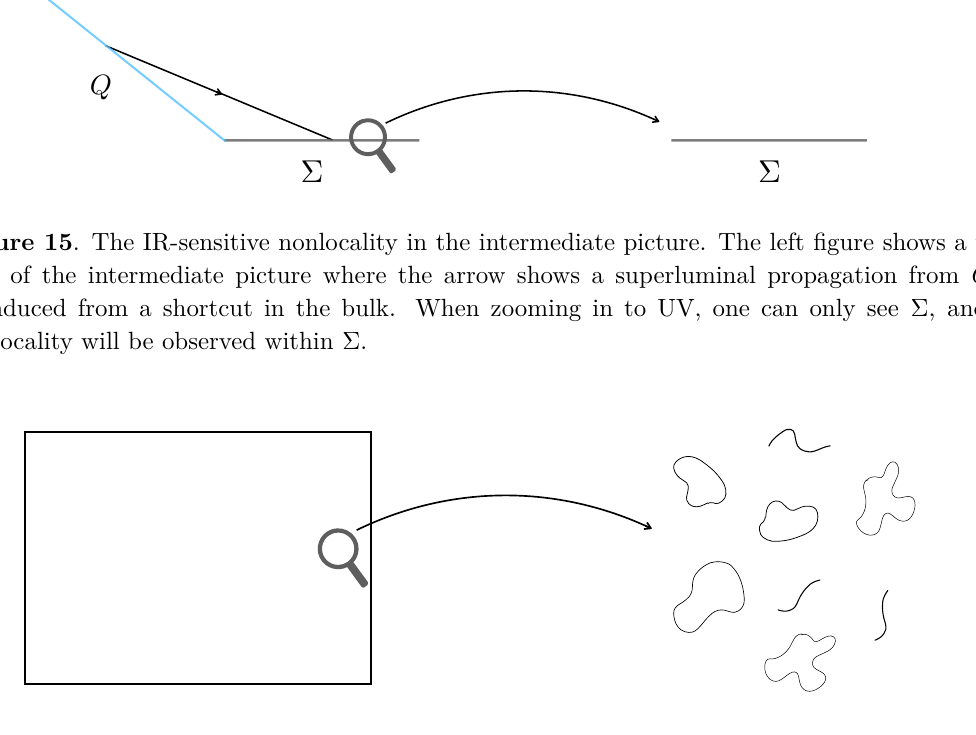
Figure 16 . The UV-sensitive nonlocality known in the string theory. When zooming in a field theory (left) which has a string origin to UV, nonlocality caused by the extension of strings becomes